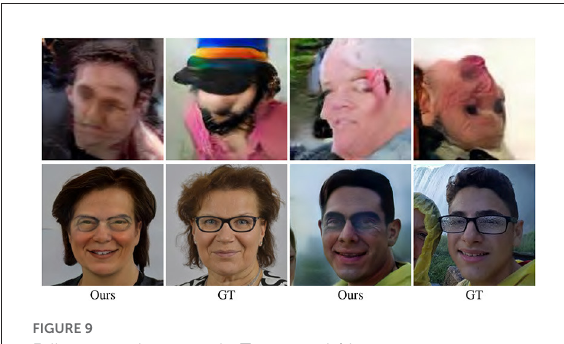
FIGURE9 Failure cases in our study. Top : step-1 (due to extreme pose conditions and expressions); bottom : step-2 (due to poor handling of occlusion by